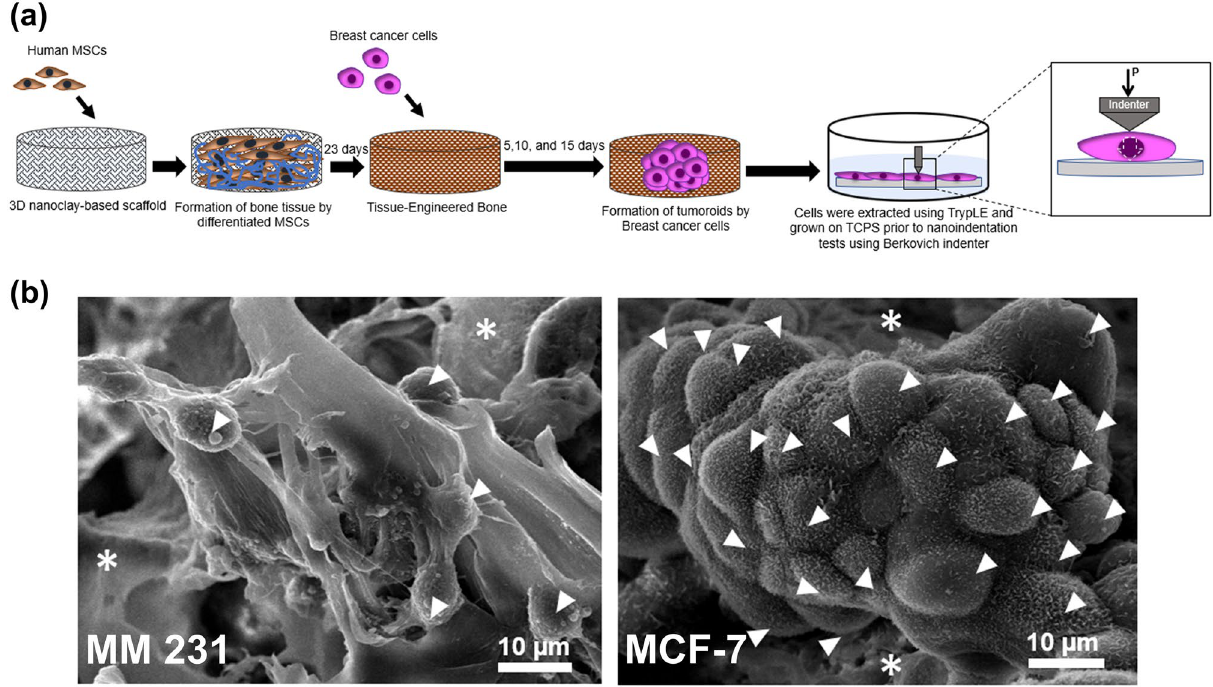
Figure 1. (a) Schematic showing steps of sequential culture MSCs/breast cancer followed by workflow of nanoindentation experiment. Dotted arrow pointing downwards indicates the amount of deformation applied (P) onto cell to obtain mechanical response. (b) Morphology of breast cancer cells MM 231 and MCF-7 grown on 3D bone-mimetic nanoclay scaffolds. Arrows indicate cells while * indicate